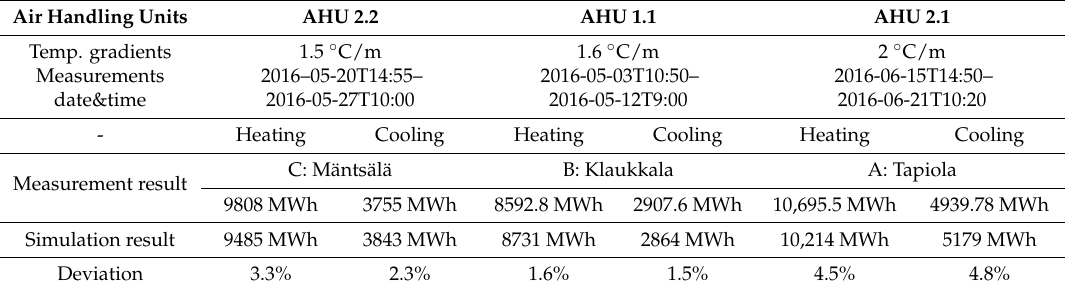
Table 2. The measurements and the simulation results of the three ice rink arenas.